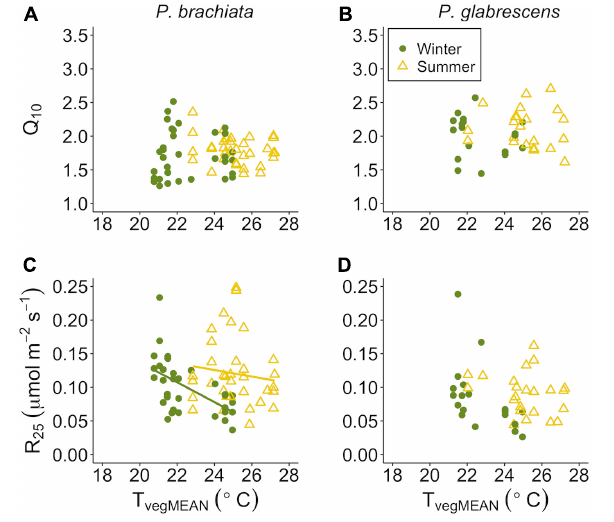
FIGURE 7 | Respiration parameter responses to mean daily vegetation temperature ( T vegMEAN ). (A) Psychotria brachiata increase in respiration for every 10 ◦ C (Q 10 ) response to T vegMEAN of winter (green circles) and summer (yellow triangles), (B) Piper glabrescens Q 10 response to T vegMEAN (C) P. brachiata rate of respiration at 25 ◦ C ( R 25 ) response to T vegMEAN , and (D) P. glabrescens R 25 response to T vegMEAN . Fit lines (green - winter; yellow – summer) indicate a significant interaction between T vegMEAN and season ( Supplementary Table S7 ). A solid black line is fit when there is a significant T vegMEAN response but no interaction ( Supplementary Table S7 ).